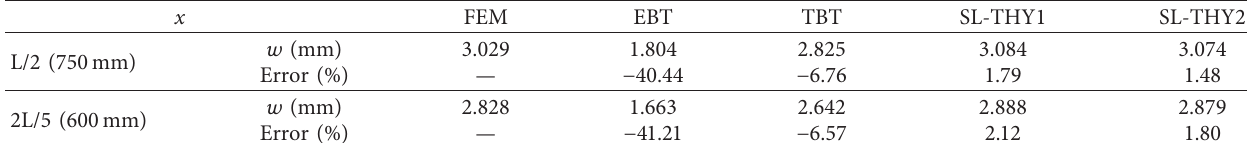
Figure 12: Comparison of vertical deflections predicted by the proposed methods (SL-THY1 and SL-THY2), EBT, TBT, and FEM analysis for the fixed-end box girder (example 2). Table 3: Vertical deflections of midspan and 2/5-span of a simply supported box girder (1B2C).